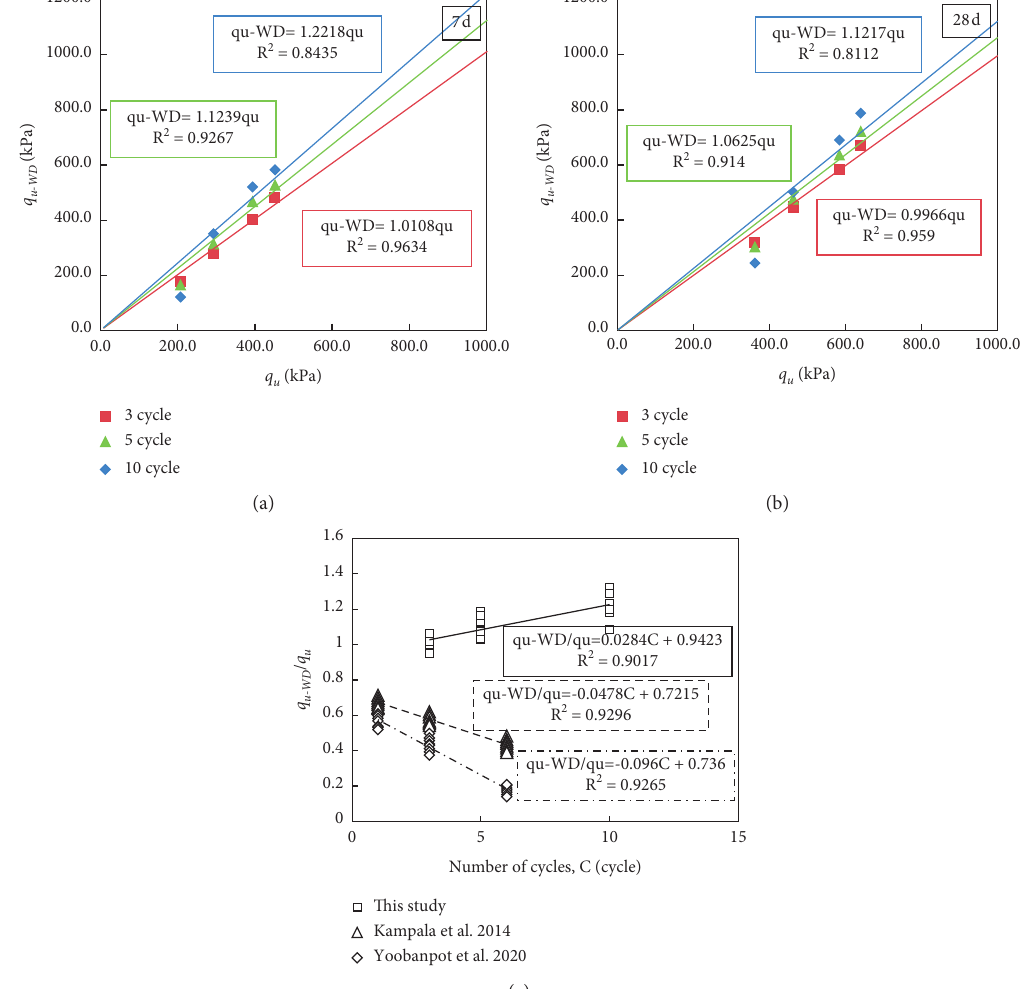
u . (a) 7 days. (b) 28 days. (c) Relationship between the normalized strength